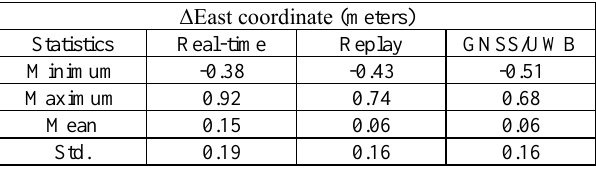
Table 5. Statistical value describing positioning errors in East direction.